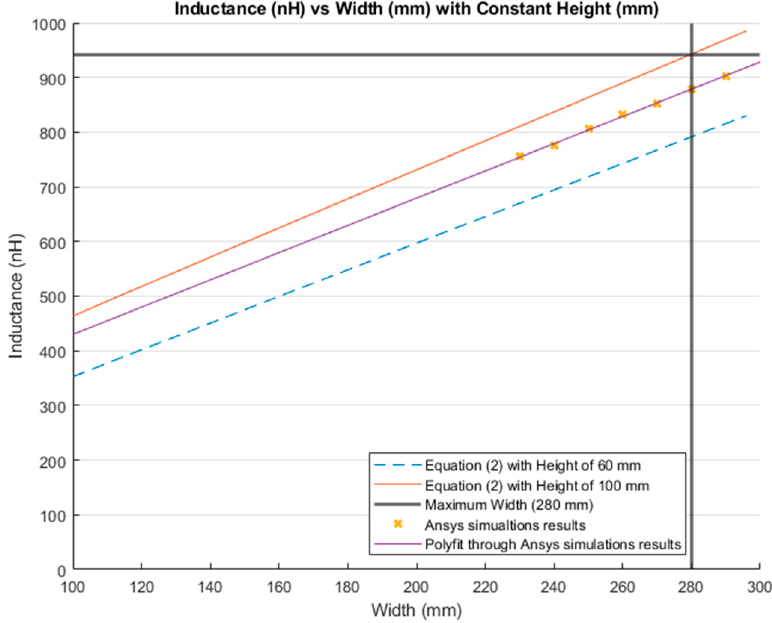
Figure 18. Comparison between theoretical inductance calculations using Equation (2) and simula- tions results with a constant height (mm).